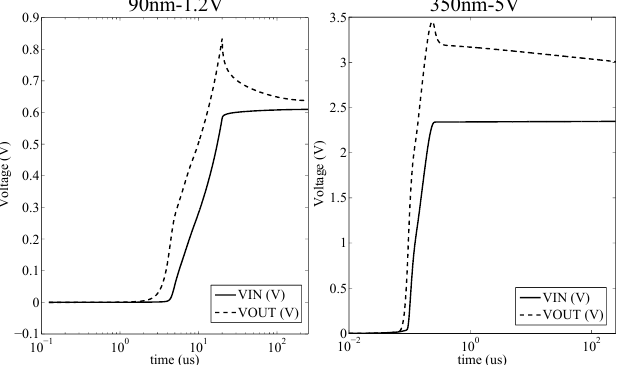
Figure 3. Pseudo-Floating Gate Amplifier (PFGA). ( a ) system level view; ( b ) symbol; ( c ) transistor level view; ( d ) equilibrium point of the PFGA as intersection of the VTC (Voltage Transfer Characteristic) curves of the inverter and the voltage buffer.